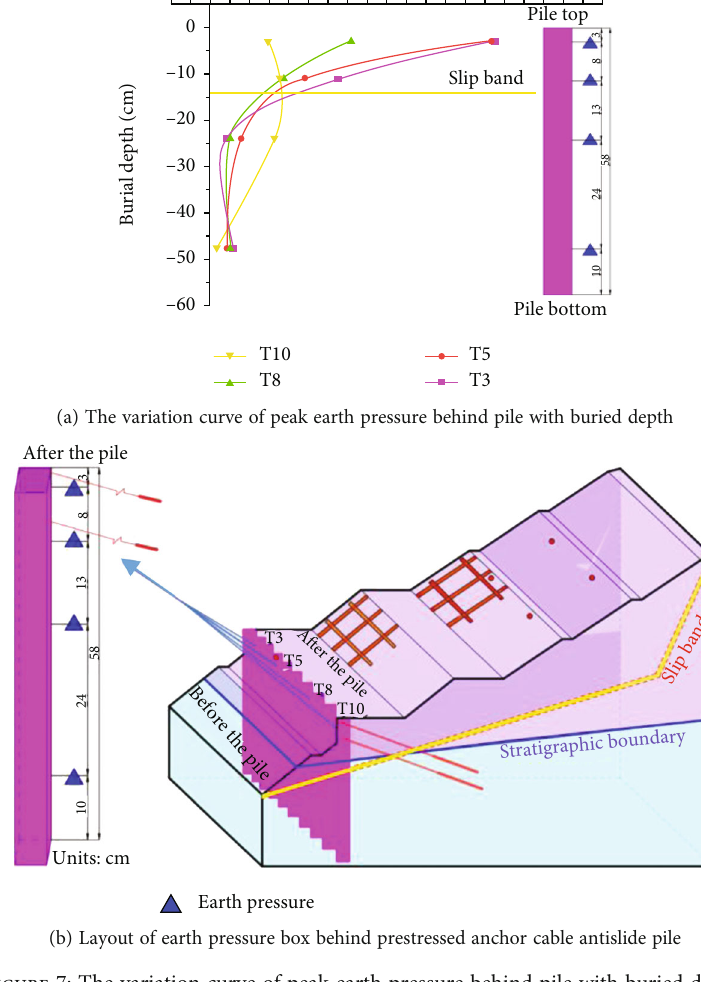
Figure 7: The variation curve of peak earth pressure behind pile with buried